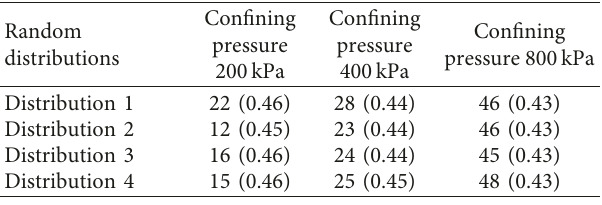
Table 9: Elastic modulus and Poisson’s ratio (in brackets) of different confining pressures and random distributions.